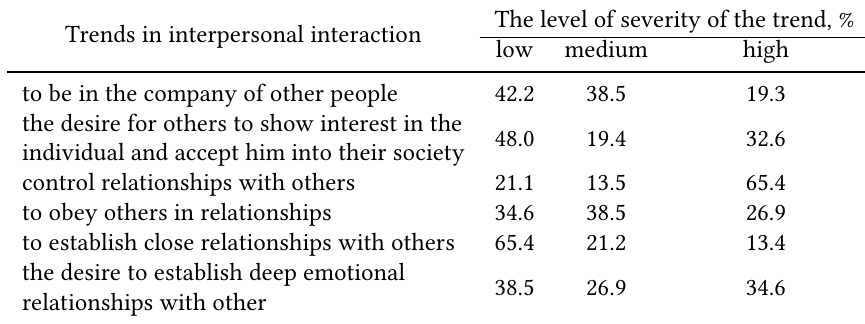
Features of interpersonal needs and behavior of employees of organisations with different forms of work. Trends in interpersonal